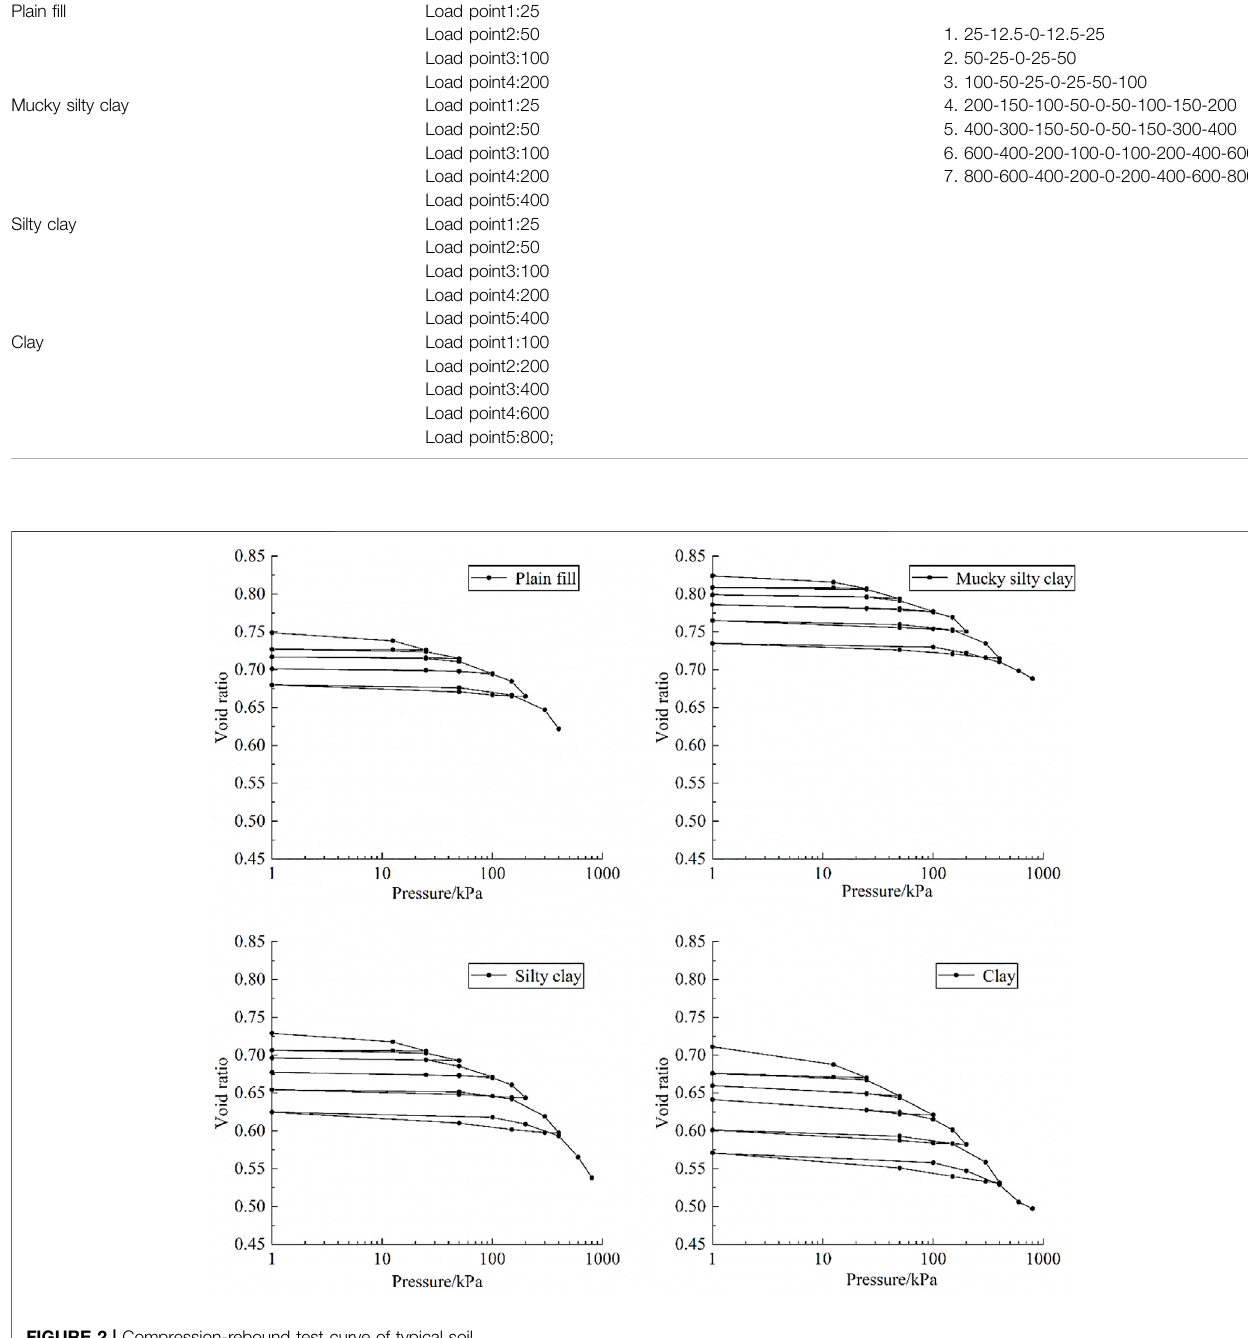
FIGURE 2 | Compression-rebound test curve of typical